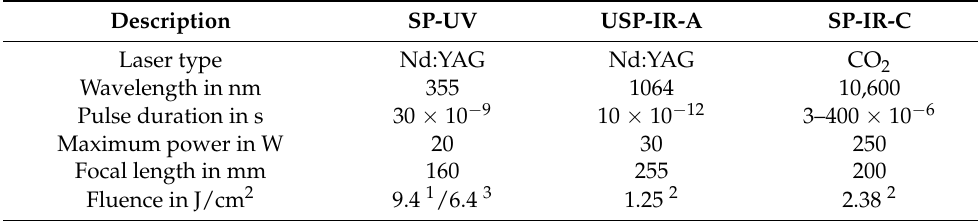
Table 2. Technical specifications and optical setups of used laser systems. Description